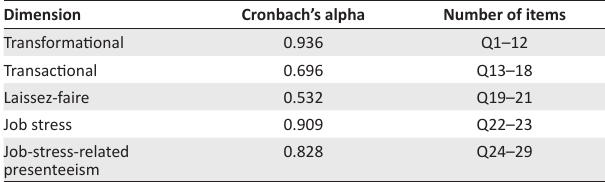
TABLE 2: Cronbach’s alpha